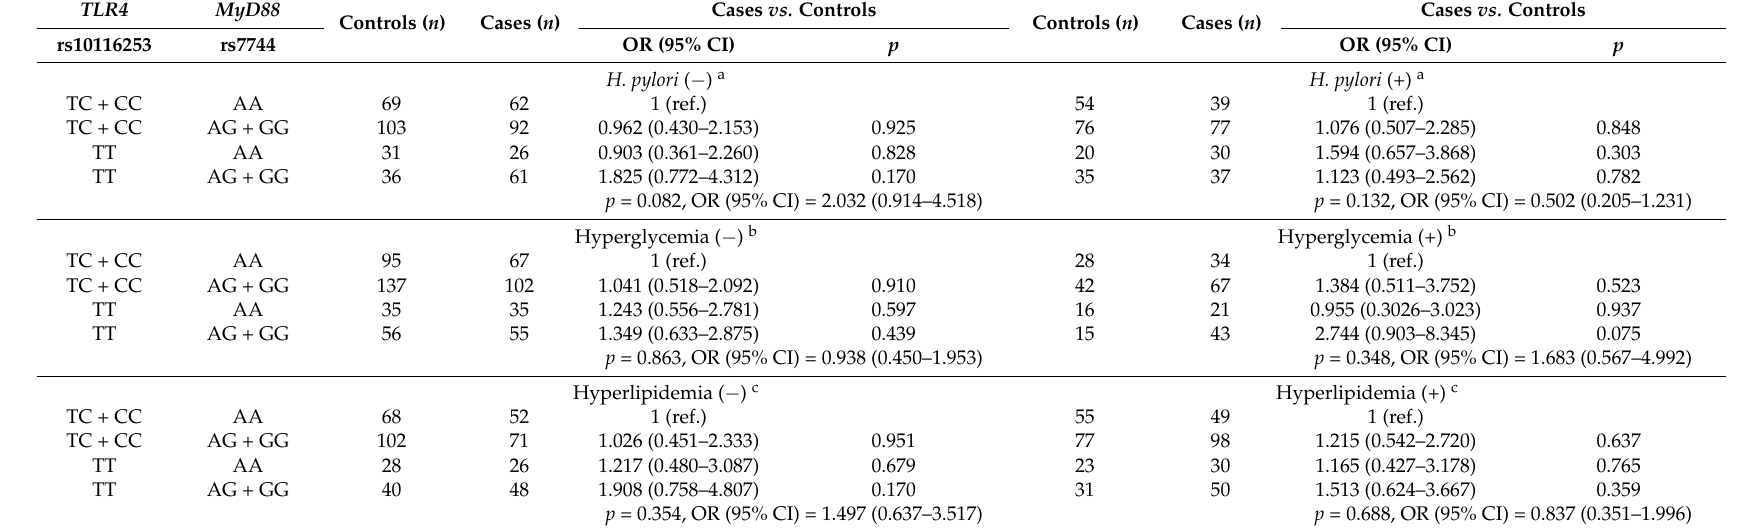
Table 4. The effect of confounding risk factors on the interaction between TLR4 rs10116253 and MyD88 rs7744 in the risk of CAD. TLR4 MyD88 Controls ( n ) Cases ( n )